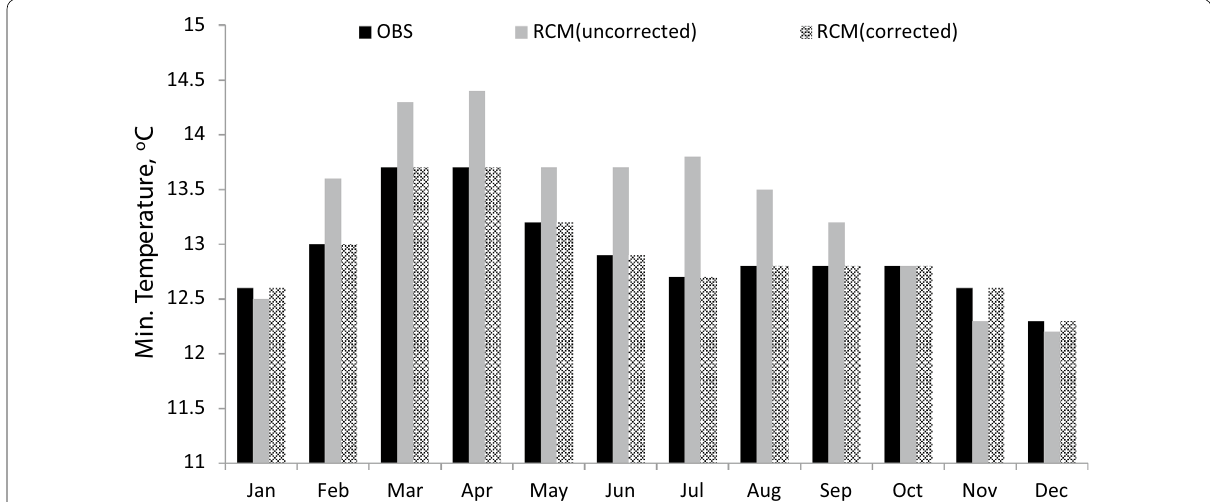
Fig. 5 Comparison of bias corrected and uncorrected RCM data of minimum temperature on the monthly